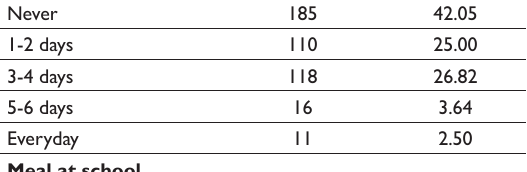
Feeding frequency in bukka/restaurant